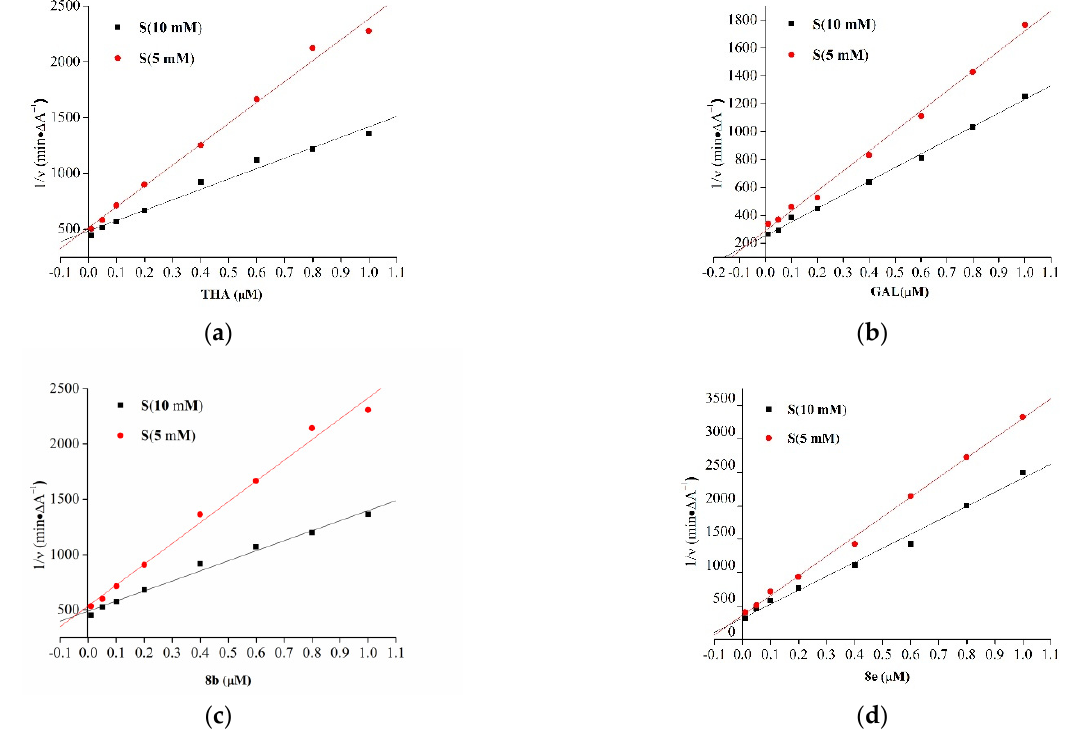
Table 2. Inhibition constants (K i ) of the target compounds against human AChE.